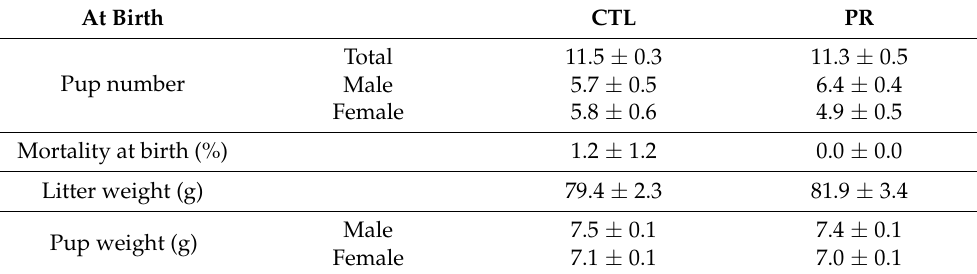
Table 2. Parturition.